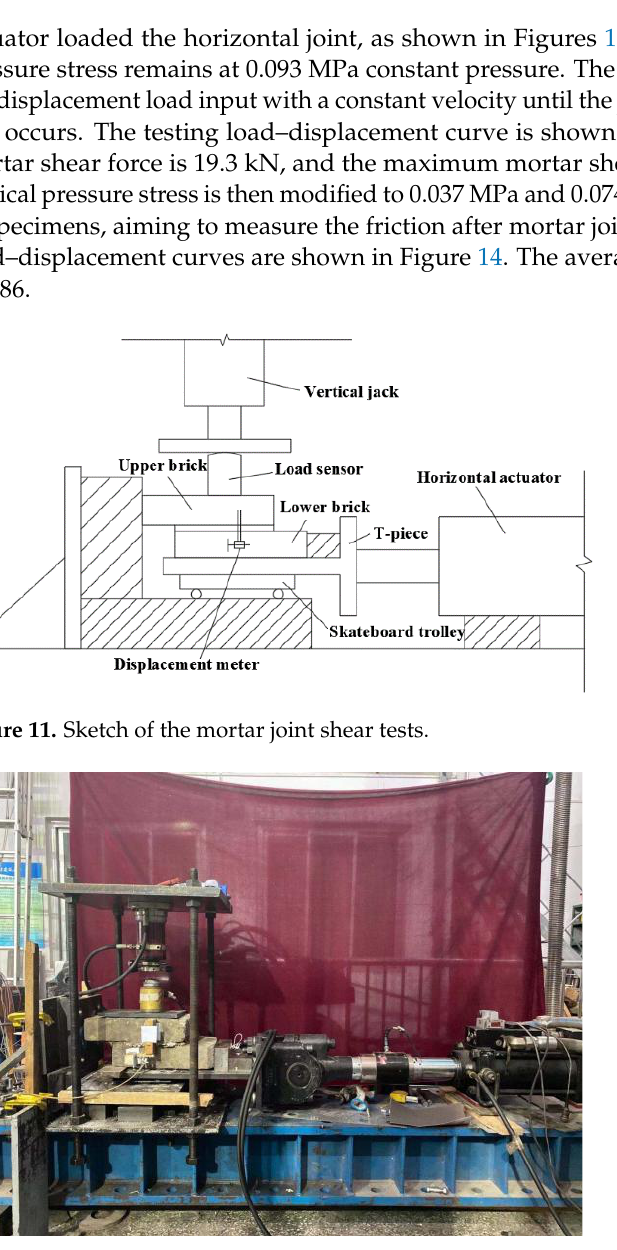
Figure 12. Test setup of mortar joint shear.